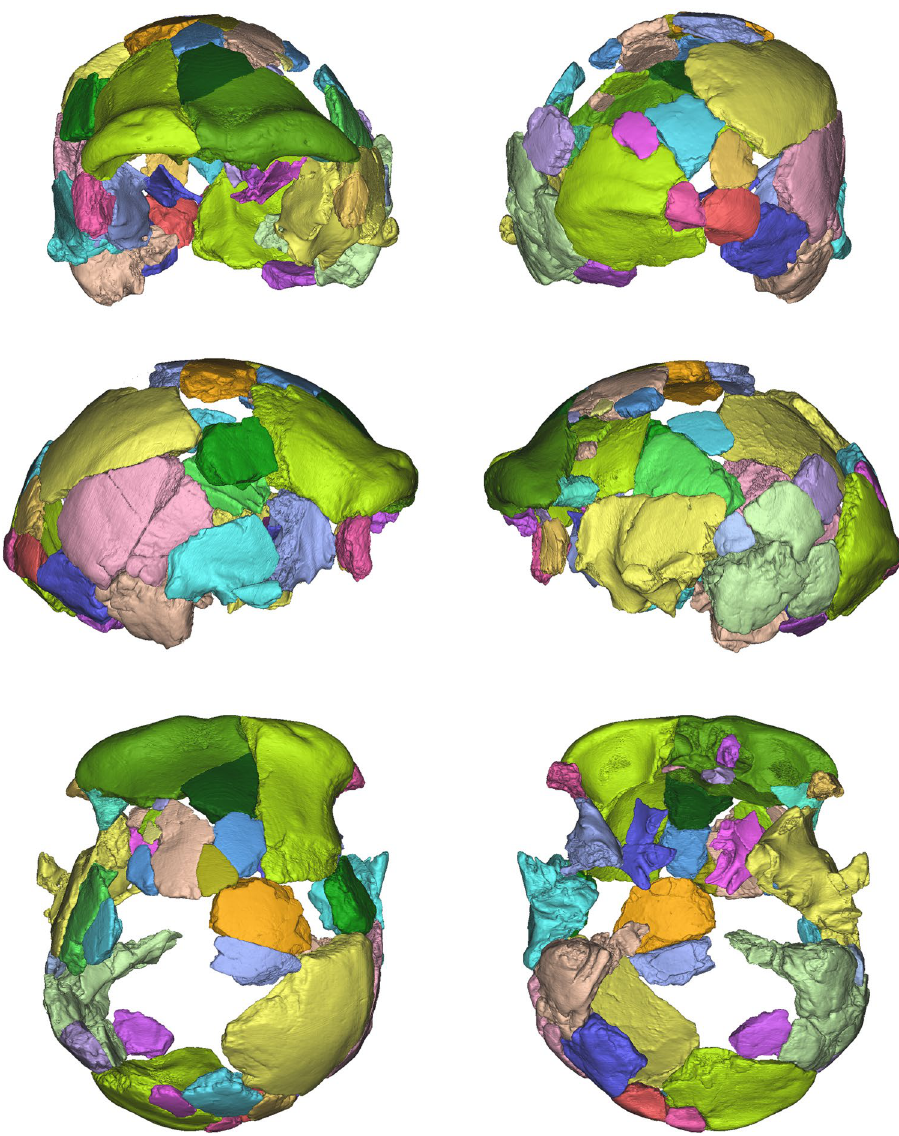
Figure 3. Six canonical views of the segmentation of the Ceprano calvarium after μ CT scans, which freed it from the plaster matrix. All the fragments included in the last physical reconstruction 3 (N = 41) were thus digitally isolated and are distinguished here by